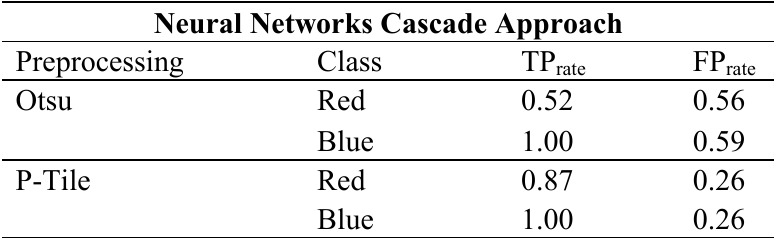
Table 5. Results of the cascade approach for